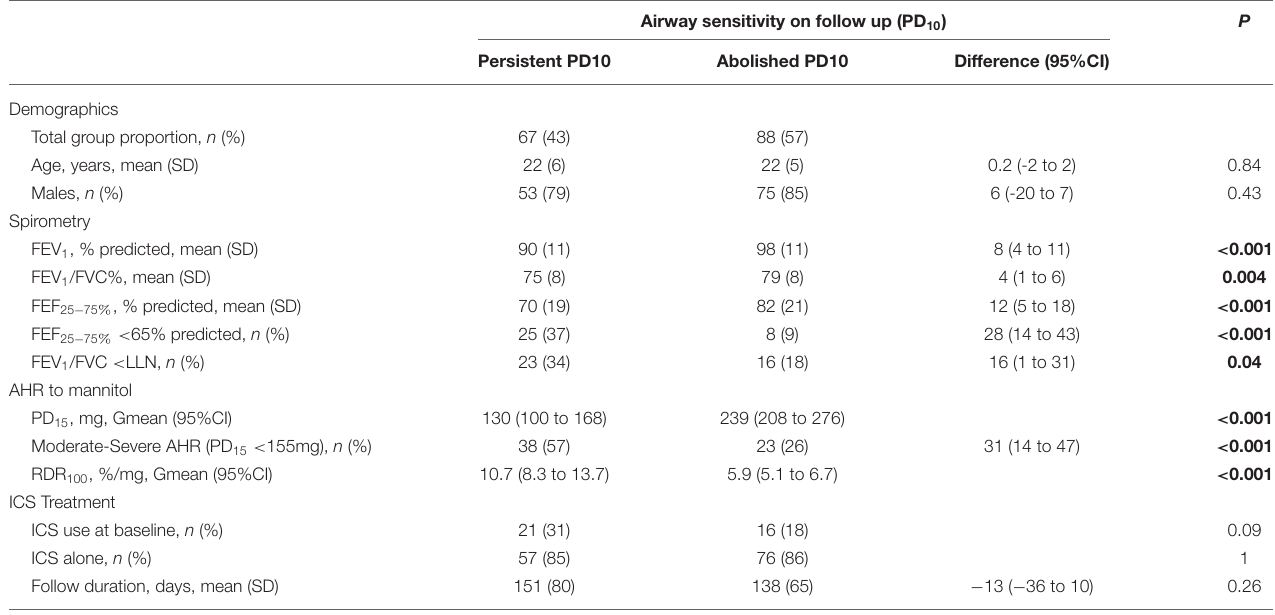
TABLE 3 | Recruits baseline demographics, spirometry, AHR and ICS treatment; Grouped based on airway sensitivity (PD 10 ) at follow-up ICS treatment visit. Airway sensitivity on follow up (PD 10 ) P Persistent PD10 Abolished